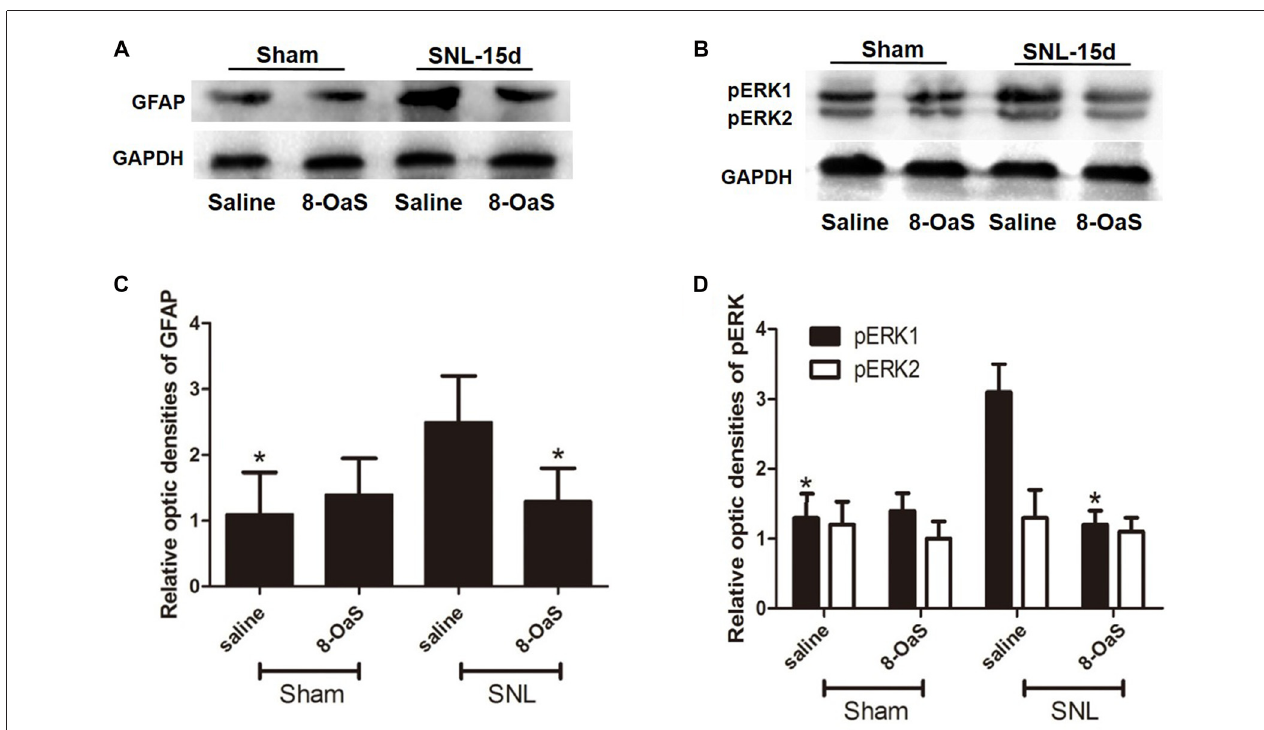
FIGURE 5 | The effects of 8-OaS administration on SNL-induced spinal GFAP and pERK upregulation. Western blot analysis showed that GFAP (A,C) and pERK (B,D) expression increased in the ipsilateral spinal dorsal horn of SNL rats at POD 15. 8-OaS reduced the expression of GFAP in the SNL model (A,C) . 8-OaS also suppressed SNL-induced pERK1 but not pERK2 (B,D) expression. ∗ P < 0.05 compared with saline-SNL group. n = 4 for each